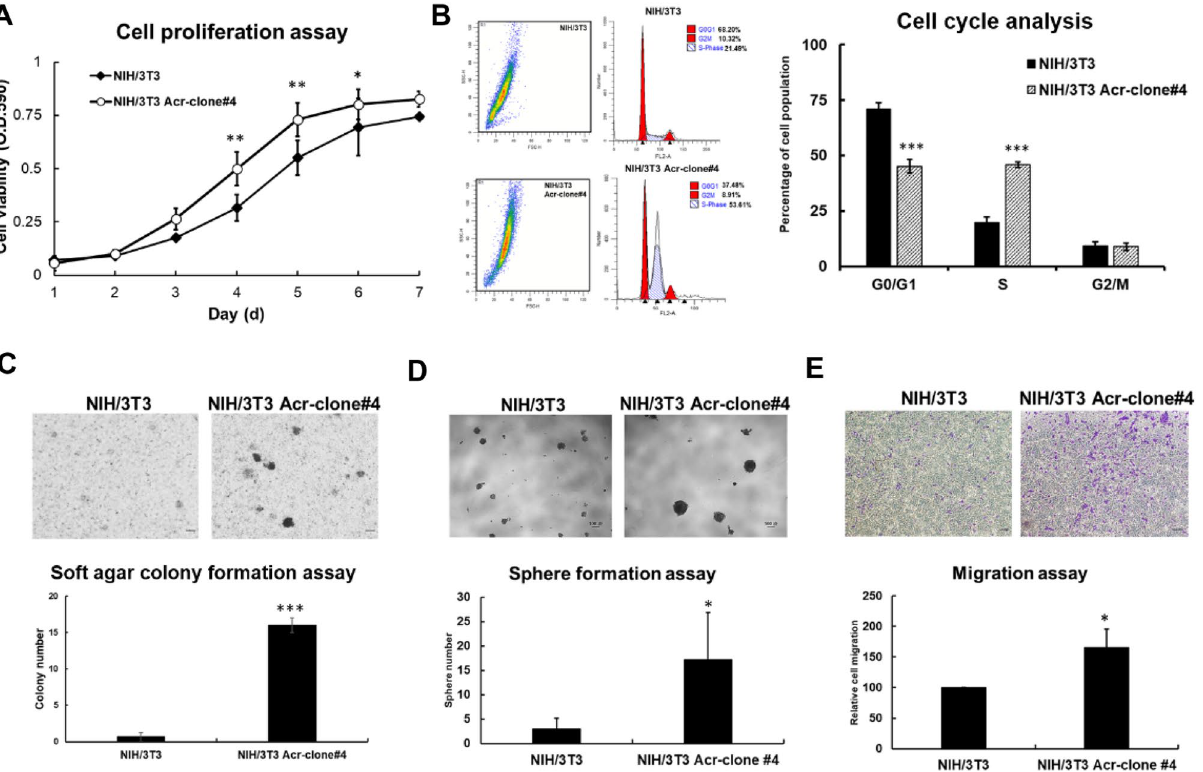
Figure 1. Acrolein induced oncogenic transformation using a cellular model of NIH/3T3 cells. NIH/3T3 cells were treated with acrolein (Acr, 7.5 μM) for one month and named NIH/3T3 Acr-clone#. (A) Cell proliferation of NIH/3T3 Acr-clone #4 cells was analyzed using MTT assays. (B) Cell cycle progression of NIH/3T3 Acr-clone #4 cells was analyzed using cell cycle analysis with PI staining. (C) Soft agar anchorage-dependent cell growth of NIH/3T3 Acr-clone #4 was analyzed using a soft agar assay. (D) The spheroid formation ability of NIH/3T3 Acr-clone #4 cells was analyzed on ultralow attachment plates. (E) The cell migration activity of NIH/3T3 Acr- clone #4 cells was analyzed using Transwell migration analysis. Scale bar: 100 µm. NIH/3T3 Acr-clone #4 had the highest cell transformation activity. Student’s t tests were used to determine statistical significance, and two- tailed p-values are shown. *p < 0.05, **p < 0.01, ***p < 0.005 compared with NIH/3T3 parental (Fig. 4E, Supplementary Fig. 3D) as well as human colon cancer cell lines, SW480 and HCT116 (Supplementary Fig. 4). These results indicate that acrolein induced oncogenic transformation through activation of the RAS/ MAPK pathways.